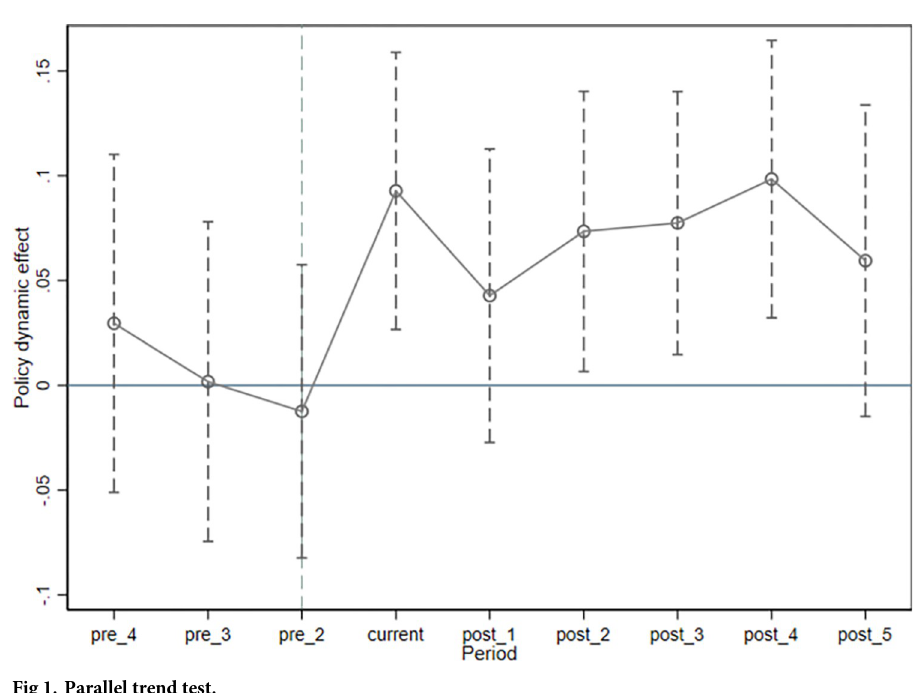
Fig 1. Parallel trend